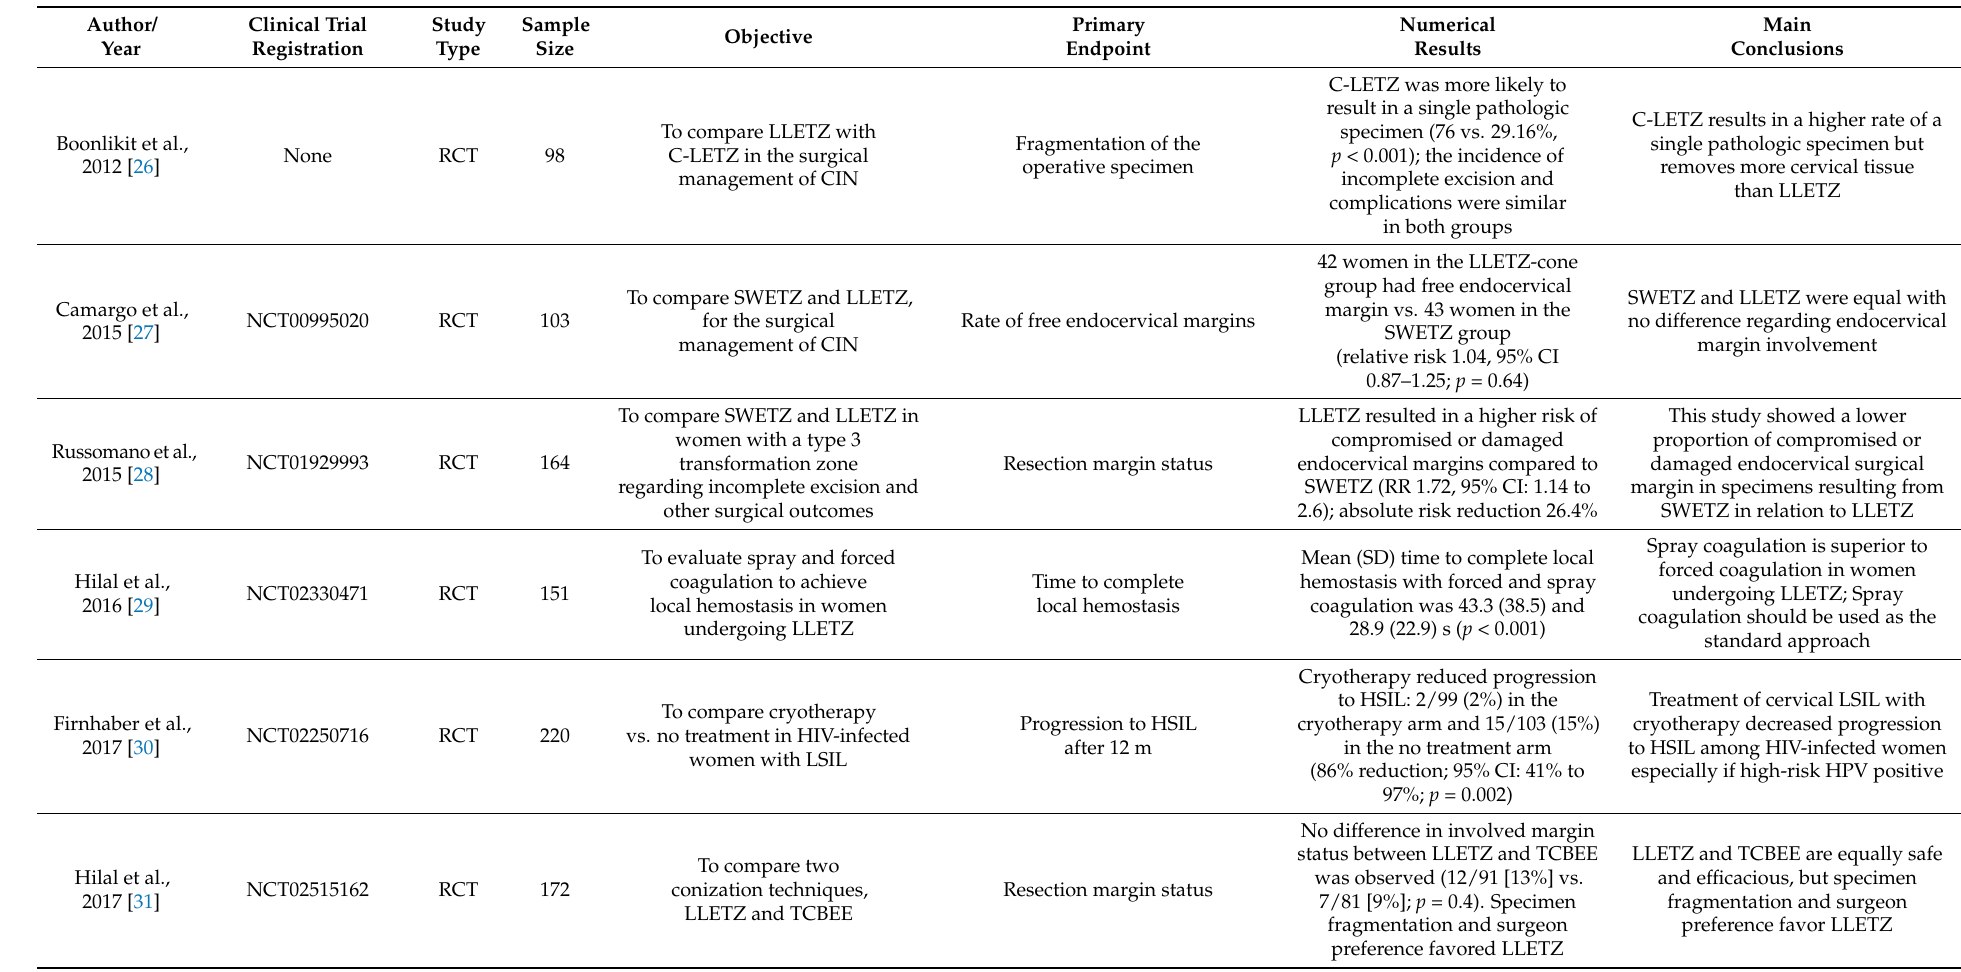
Table 2. Clinical characteristics of studies reporting on therapeutic procedures in women with cervical